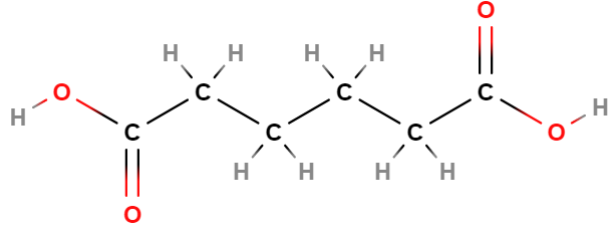
Figure 8. Structure of adipic acid (C 6 H 10 O 4 ) .